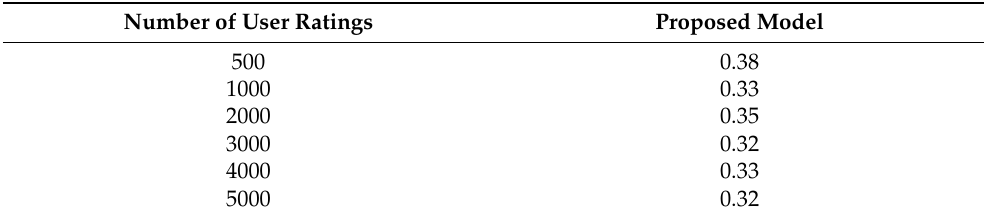
Table 4. RMSE according to the sizes of the testing sets.